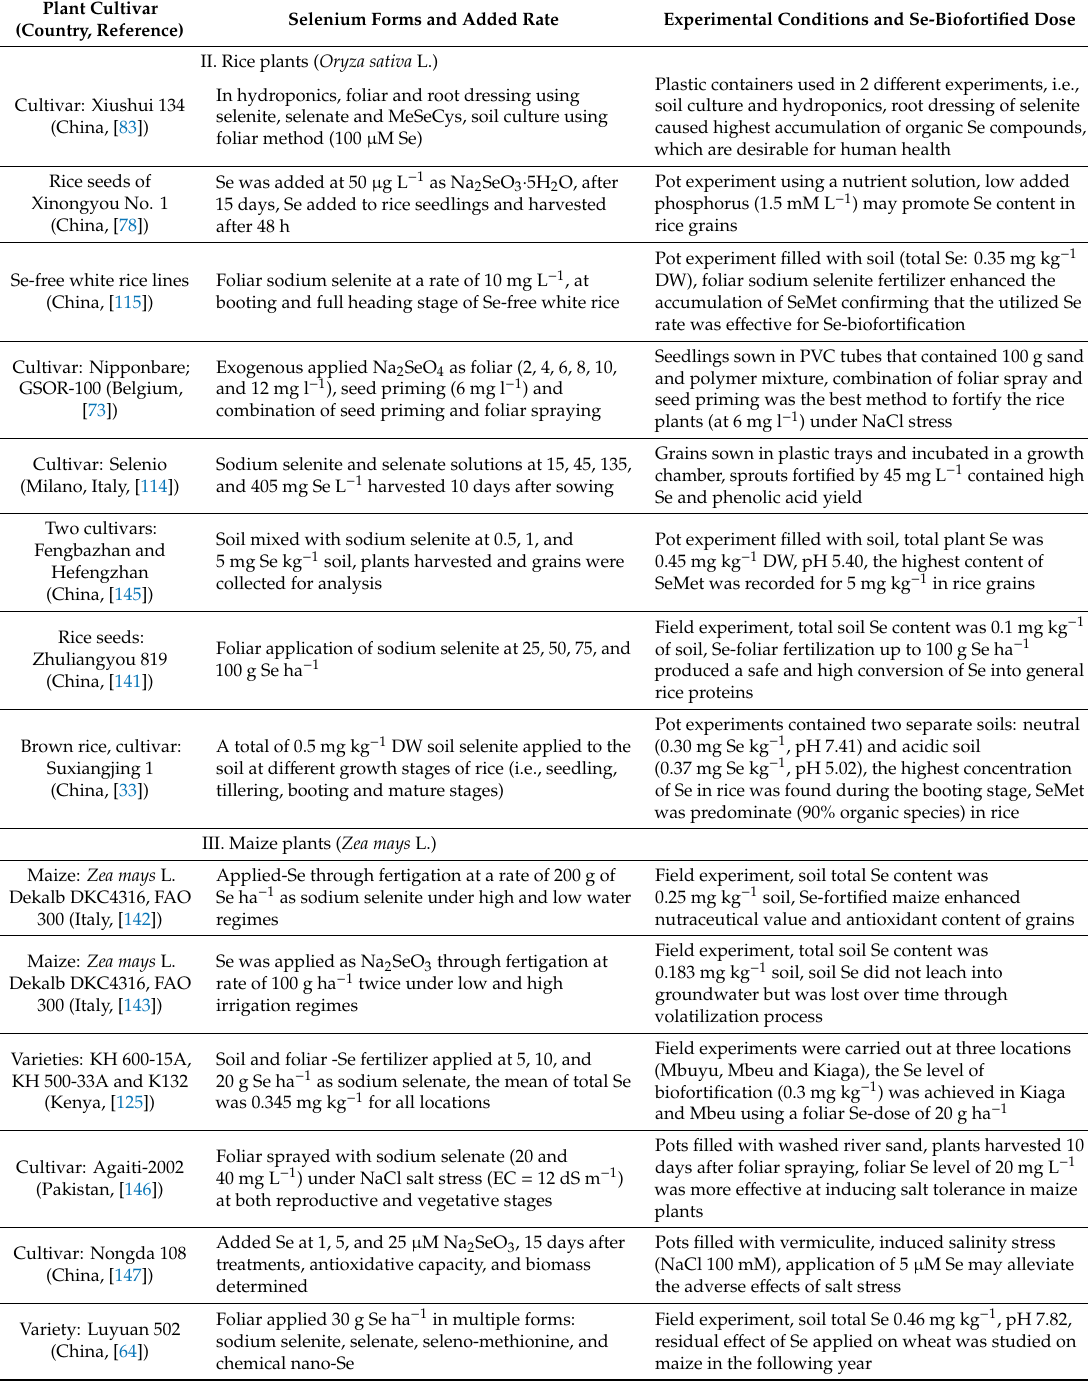
Foliar sodium selenite at a rate of 10 mg L − 1 , at booting and full heading stage of Se-free white rice